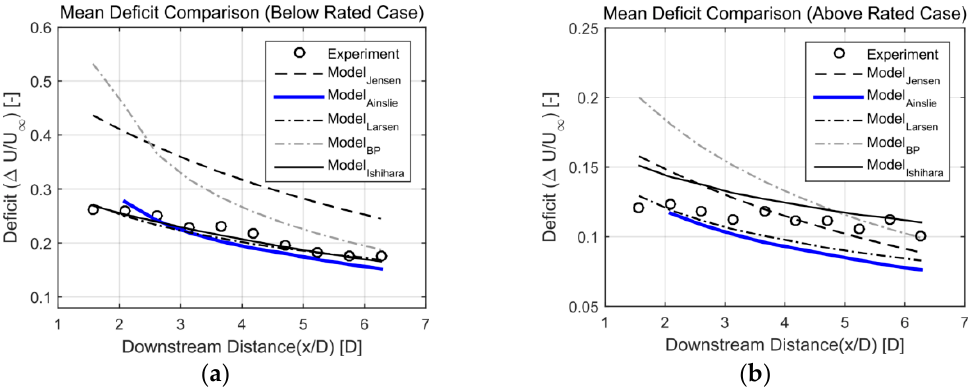
Figure 6. Deficit comparison with downstream distance: ( a ) below rated case ( C T = 0.8), ( b ) above rated case ( C T = 0.36).